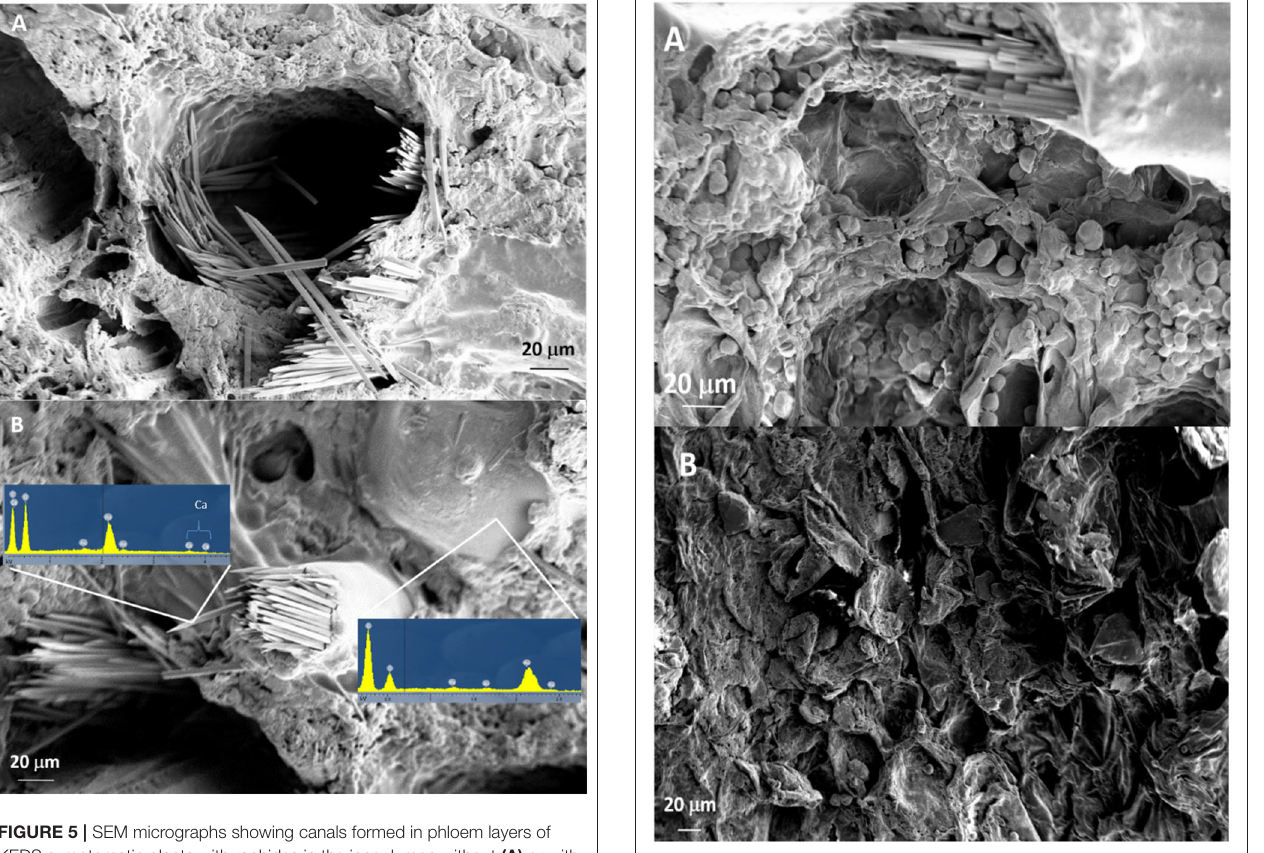
FIGURE 6 | SEM micrographs showing the phloem layer with (A) or without (B) starch granules of roots from Ridged + Compost (RC) or Control (C) treatments,